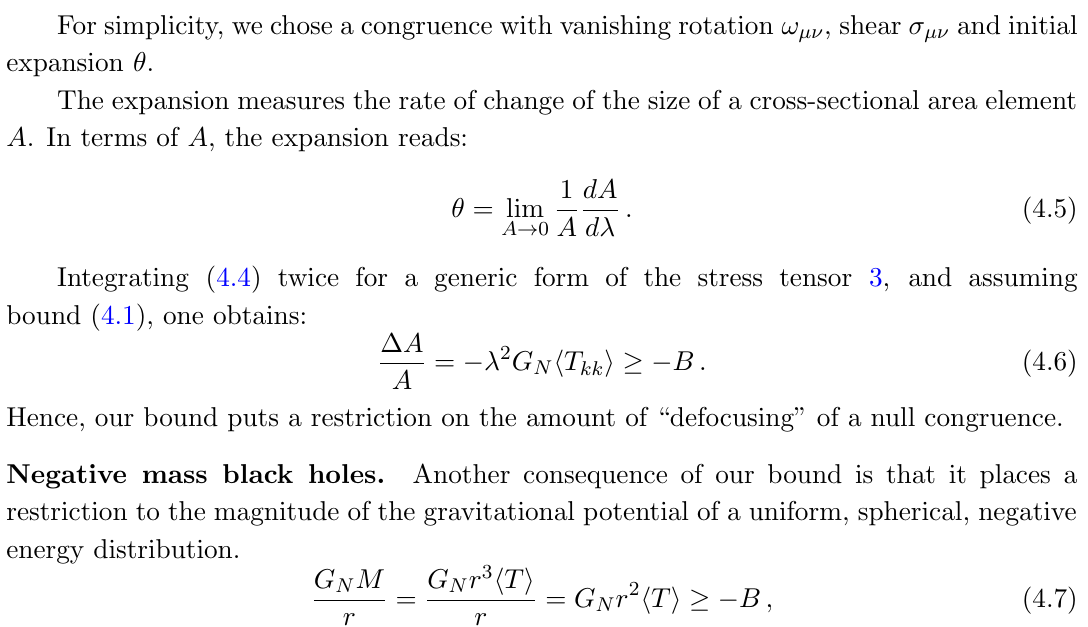
Figure 3 . Null congruence of initial area A 0 going through a concentration of negative energy (light blue). The null congruence emerges dilated, but our bound guarantees that the growth of its area remains